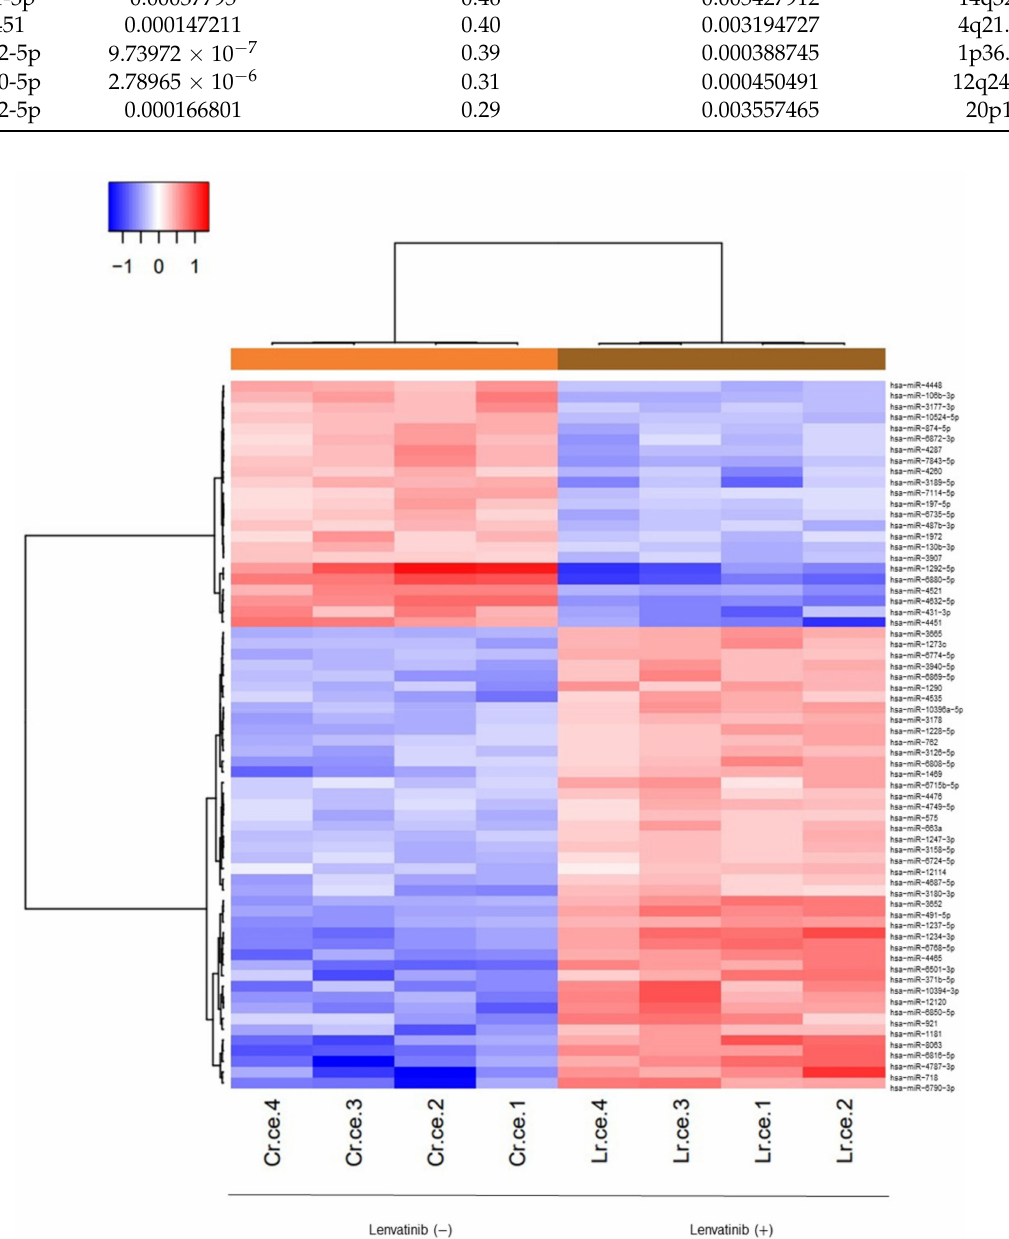
Figure 6. Lenvatinib affects miRNA expression. Hierarchical clustering of differentially expressed miRNAs from Huh-7SR cells incubated with 10 µ M lenvatinib or DMSO for 24 h. Fold Change >1.5 or <0.67, p <